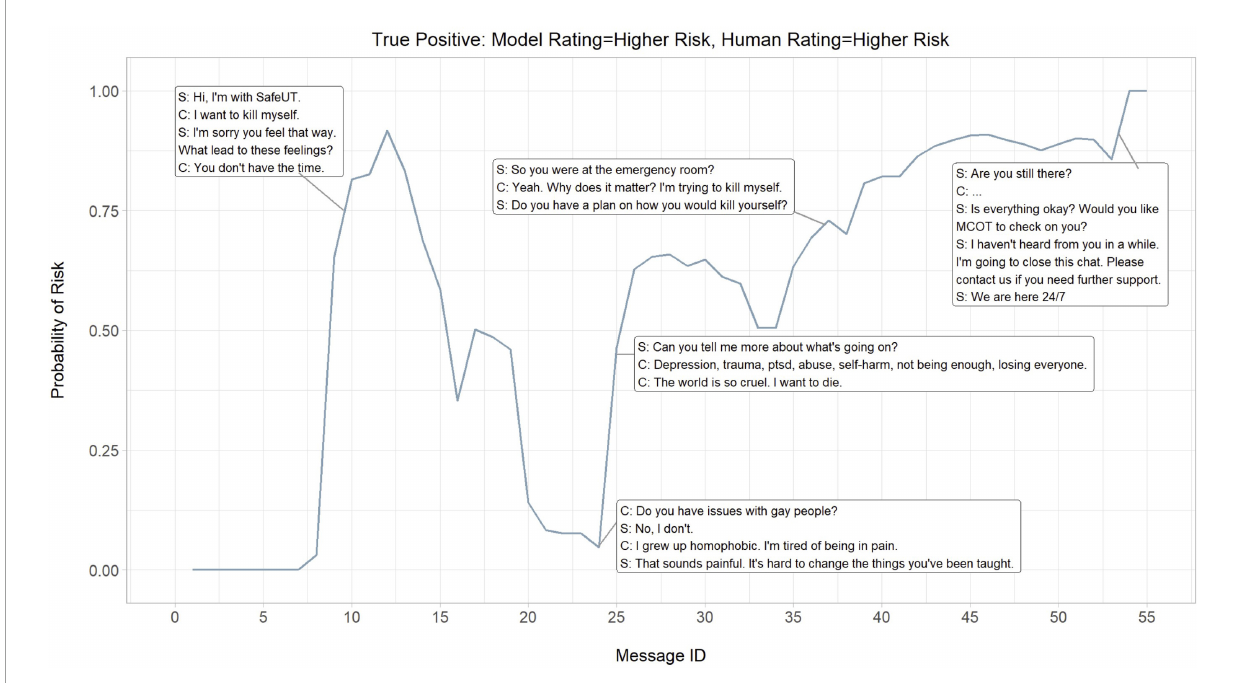
FIGURE3 Dialogue risk curves: Model rating = higher risk, Human rating = higher risk (True positive). S, SafeUT counselor; C, SafeUT client; MCOT, Mobile Crisis Outreach Team. Crisis counseling encounter has been fictionalized to maintain confidentiality.